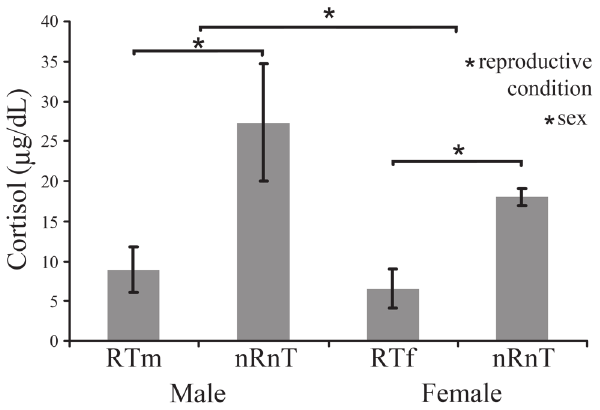
Fig. 6. Plasma cortisol levels in reproductive territorial (RT) and non reproductive non territorial (nRnT) males and females (N = 4). Cortisol levels were higher in males than females. Non Reproductive individuals presented higher levels than reproductive ones for both sexes (p<0,05). No significant interaction was detected between sex and reproductive state.